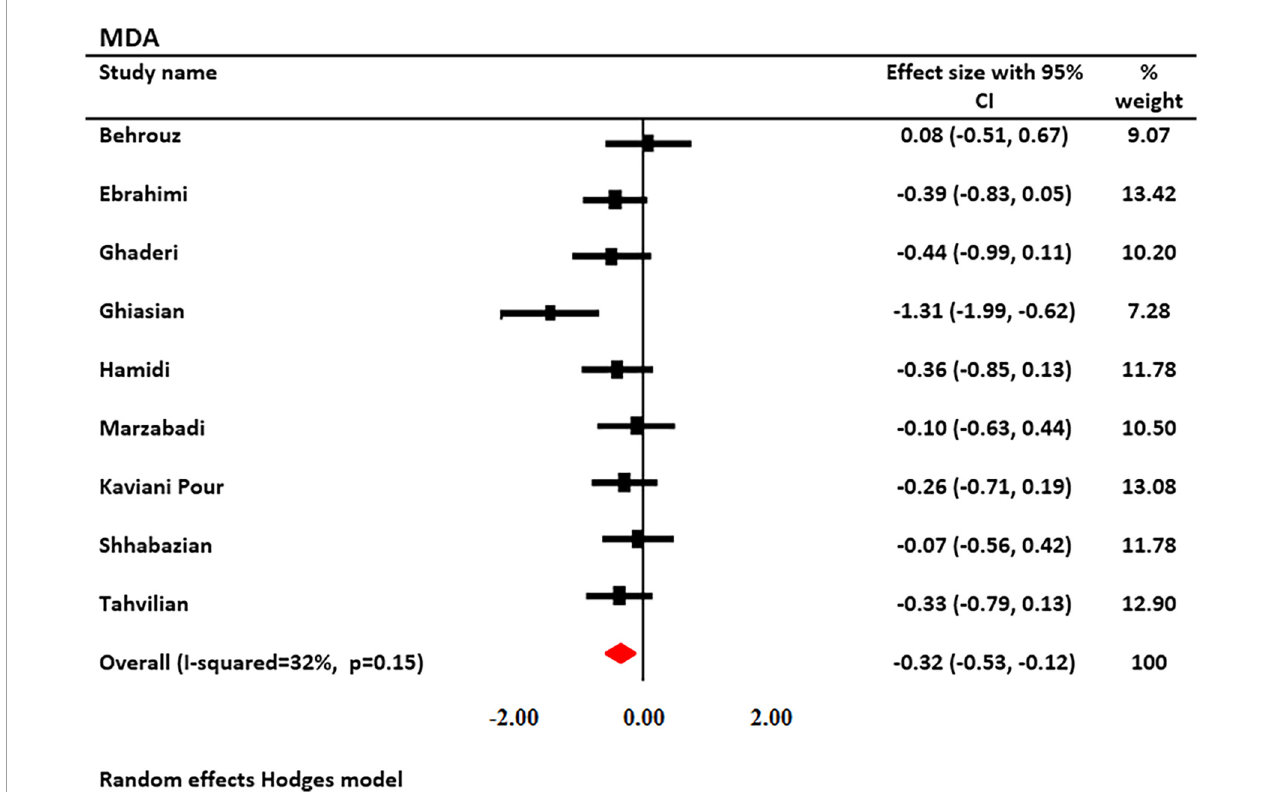
FIGURE3 Forest plot showing the summary effect size for malondialdehyde (MDA) levels between saffron and placebo groups.